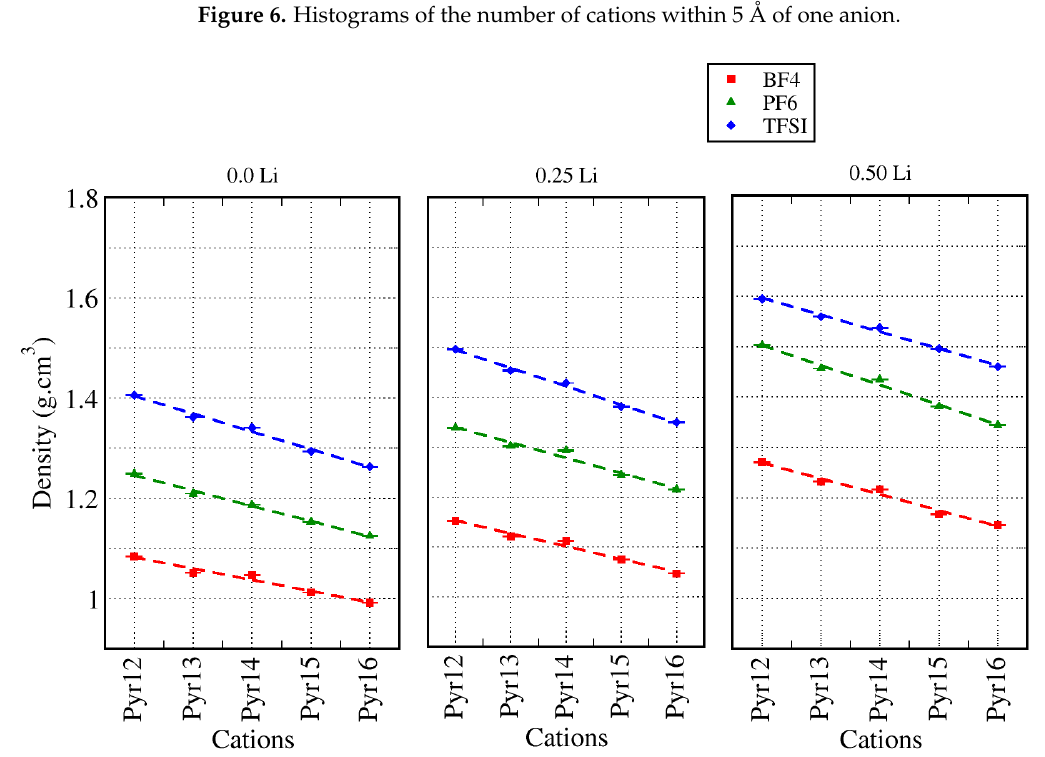
Figure 6. Histograms of the number of cations within 5 Å of one anion.